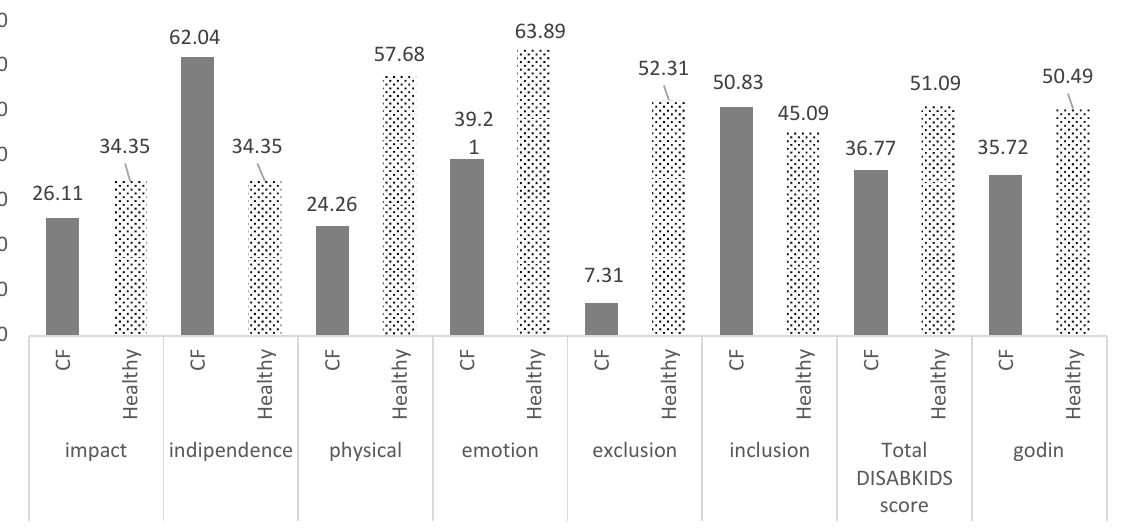
Figure 2. Healthy and patient participants’ quality of life (DISABKIDS questionnaire) and physical activity (Godin Q).